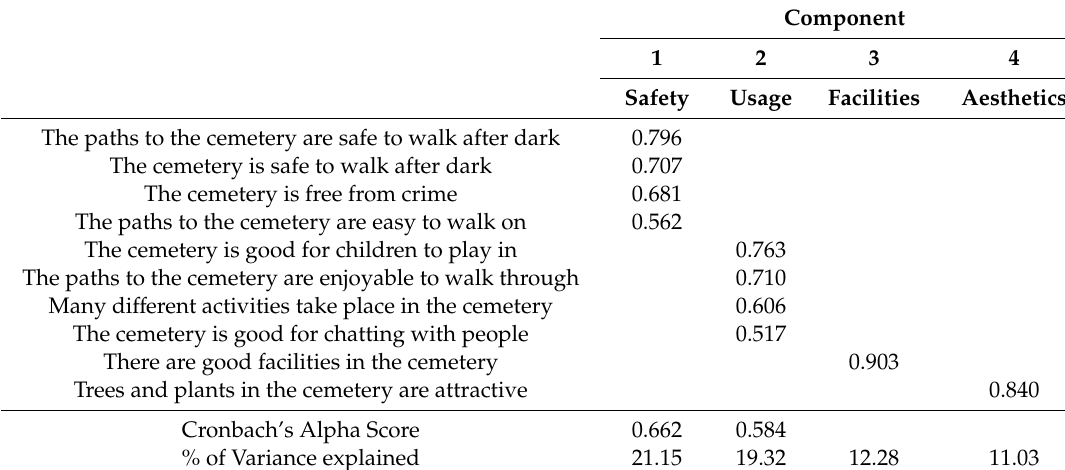
Table A1. Factor analysis of the Neighbourhood Open Scale in the cemeteries ( N =